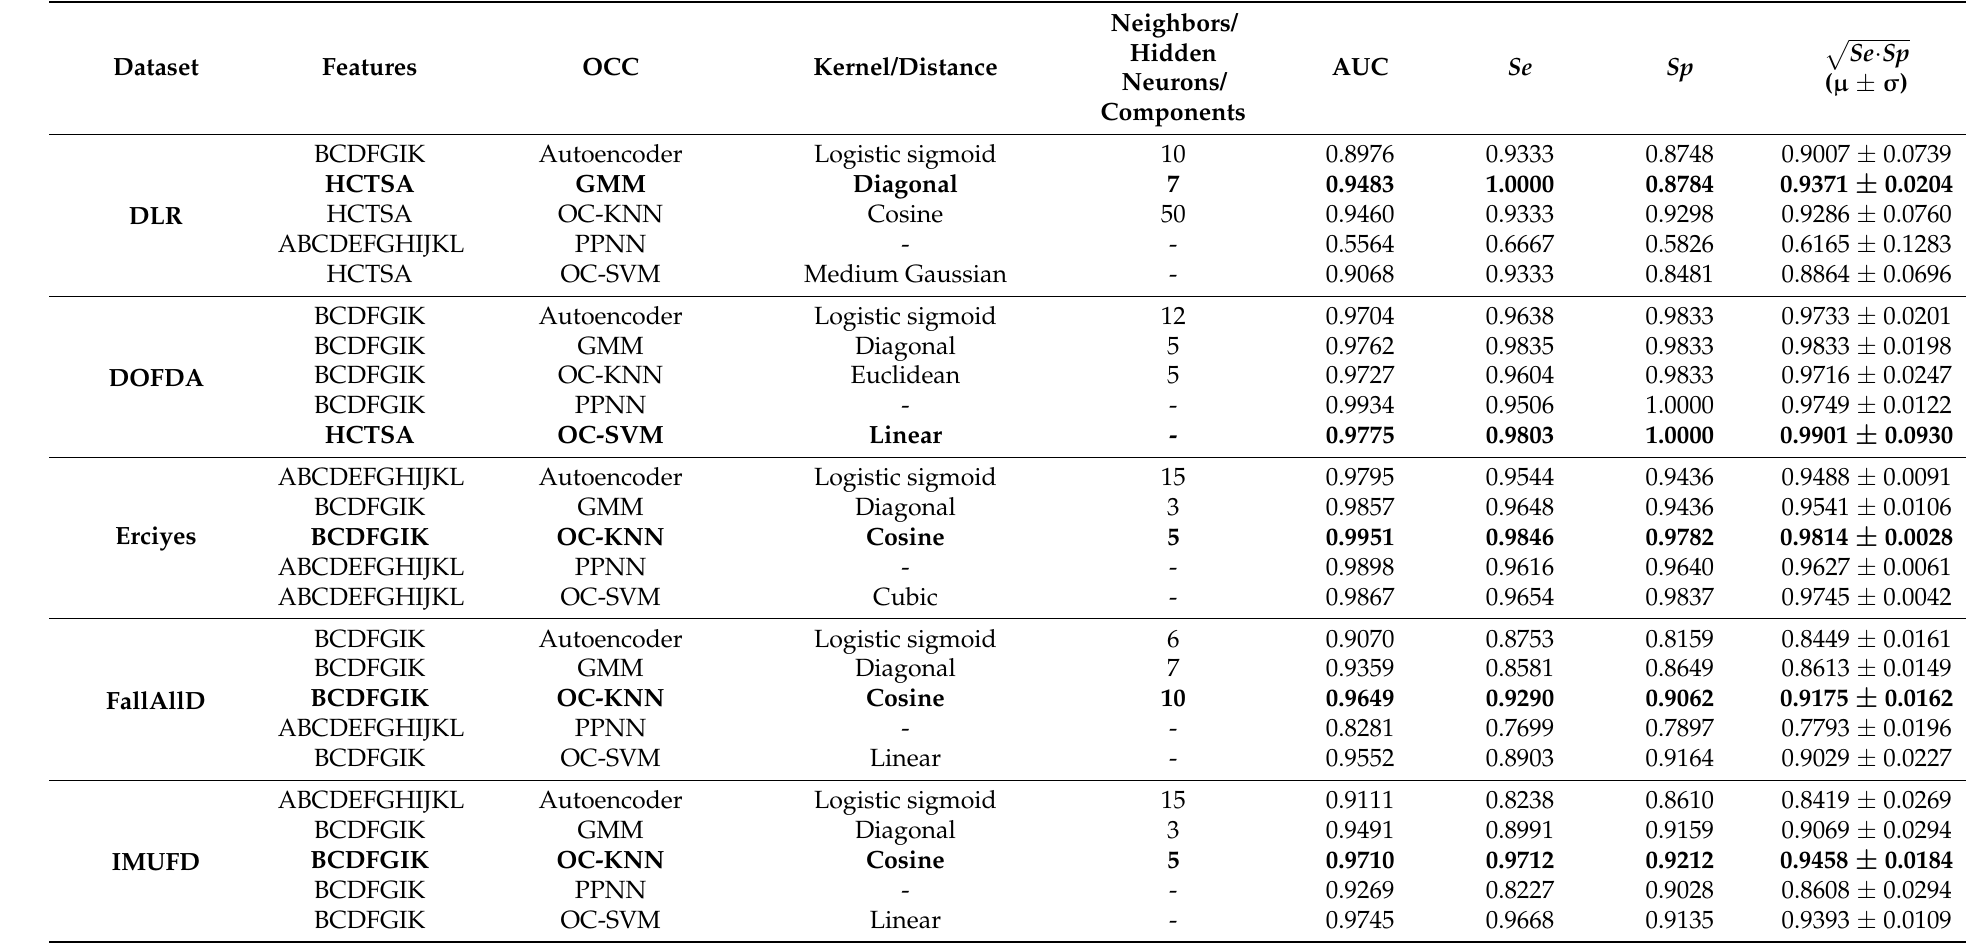
Table 6. Performance metrics (AUC, Se, Sp, and